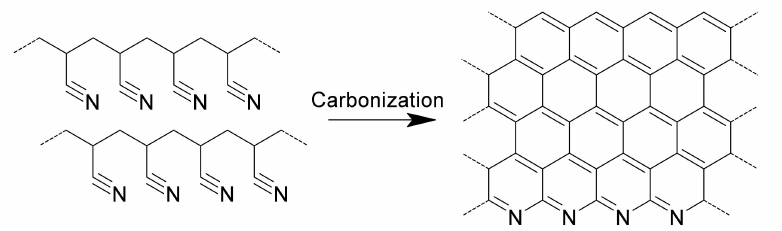
Figure 2. Chemical structure of sp 2 carbon produced after heat treatment of